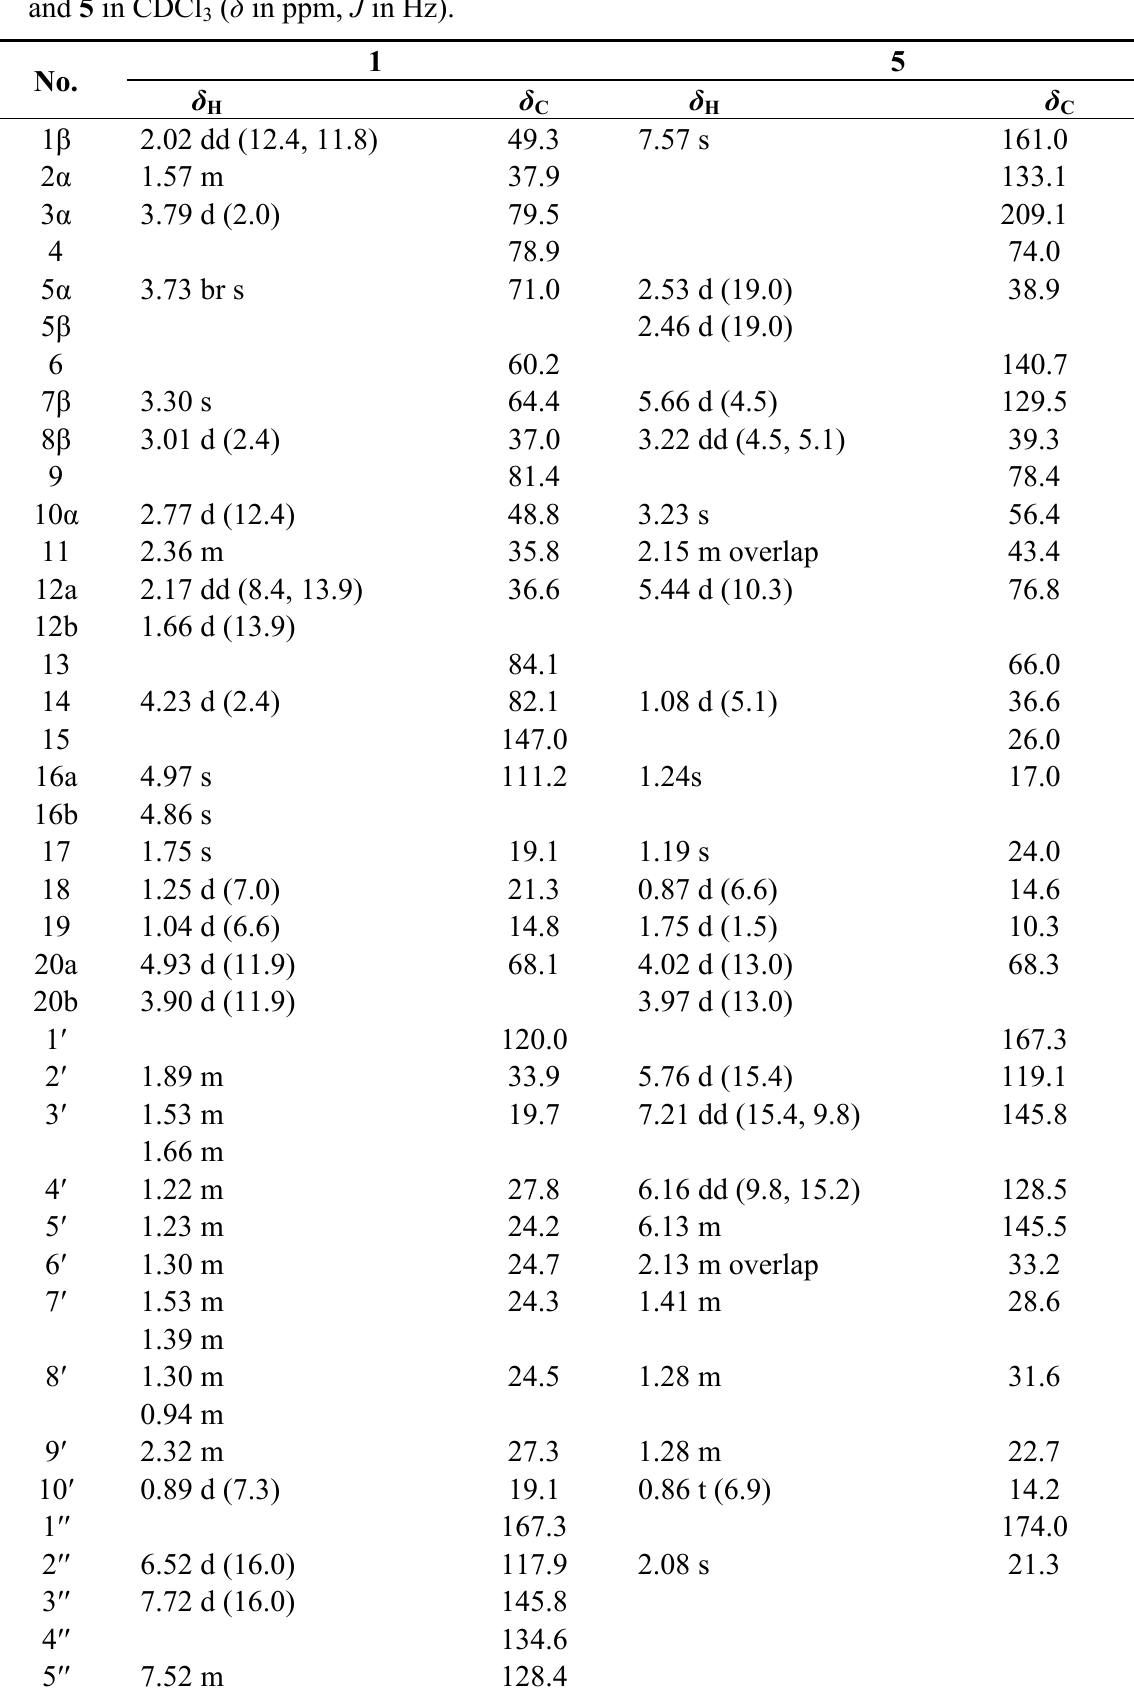
Table 1. 1 H-NMR (400 MHz) and 13 C-NMR (100 MHz) Spectral Data of Compounds 1 and 5 in CDCl ( δ in ppm, J in 3